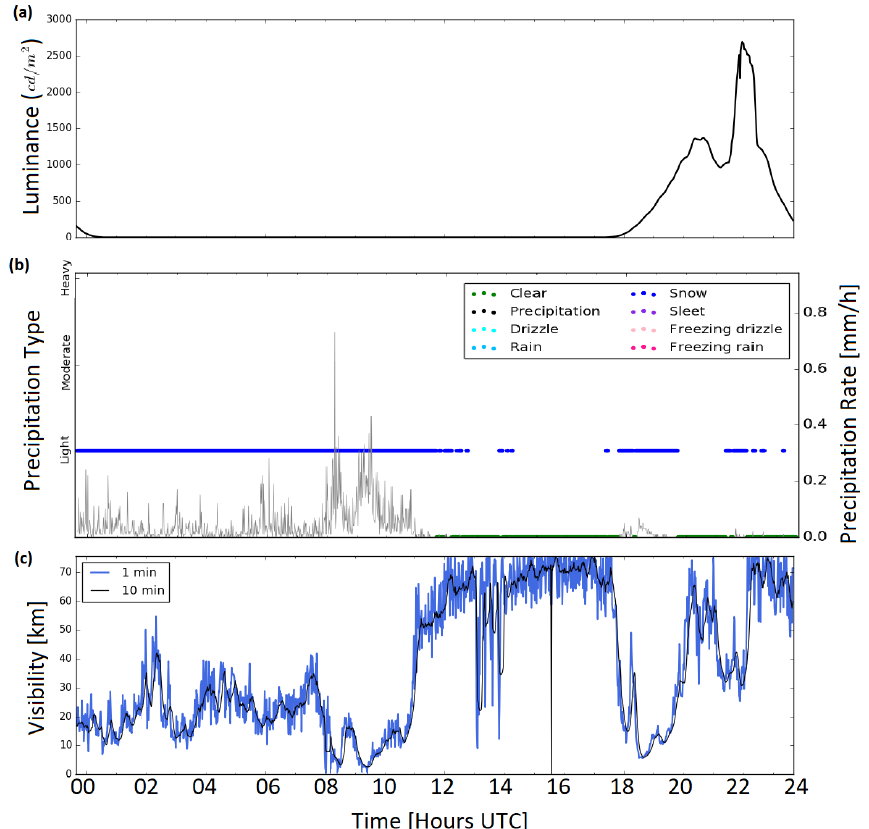
Figure 9. FS11P observations at Whitehorse during the blizzard on 16 December 2019: (a) luminance, (b) precipitation rate (grey) based on pre-defined intensity thresholds (mmh − 1 ) and type (colour-coded), and (c) averaged 1min (blue) and 10min (black) surface visibility during and after the